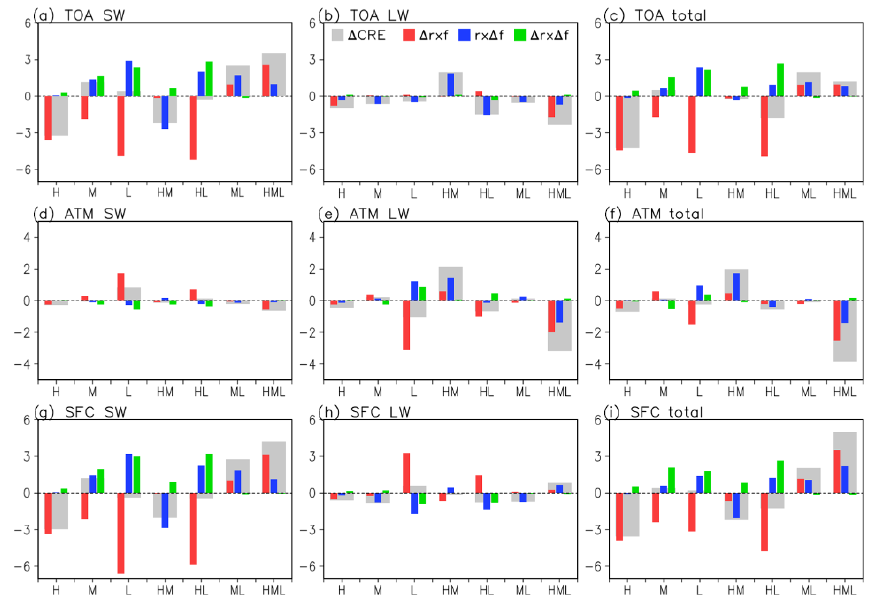
Figure 6. Decomposition of all-sky CRE error (Eq. 1) for GEOS-5 CVS classes when the GN overlap assumption is used. Gray bars represent the overall all-sky CRE error, and the remaining bars represent contributions to that error as follows: red bars represent overcast CRE errors, blue bars RFO errors, and green bars covariation errors. The nine panels represent all combinations of CRE, namely SW, LW, total at TOA, SFC, and within